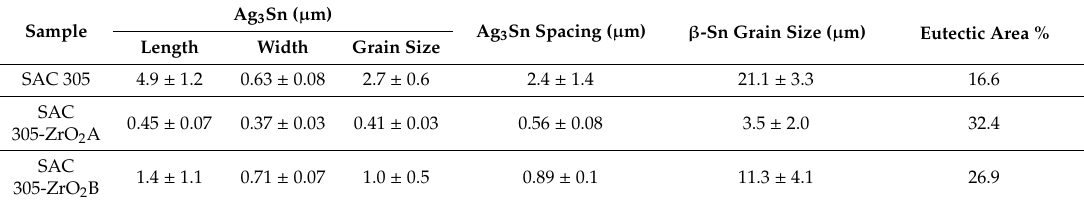
Table 1. Average grain size, Ag 3 Sn spacing and eutectic area percentage for the as-reflow monolithic and ZrO 2 reinforced SAC / Cu